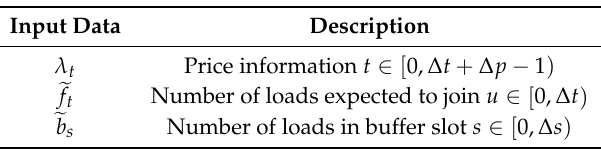
Table 1. Initial